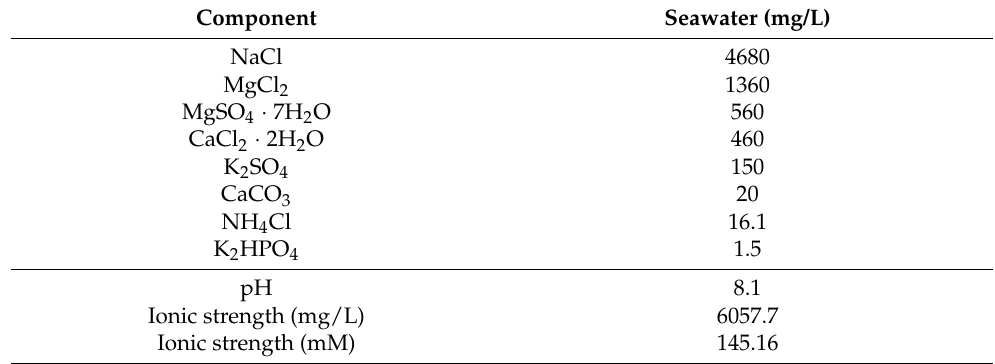
Table 3. Synthetic seawater composition used in the study, adapted from